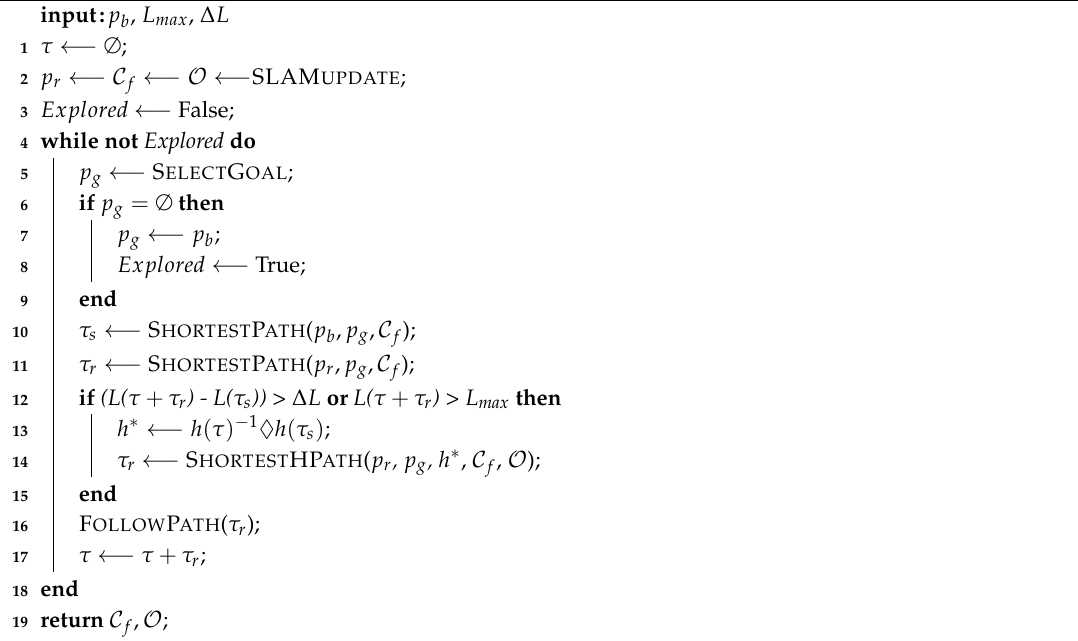
Figure 3. Flowchart representing the proposed exploration algorithm. Algorithm 1 Tether-aware exploration algorithm, general